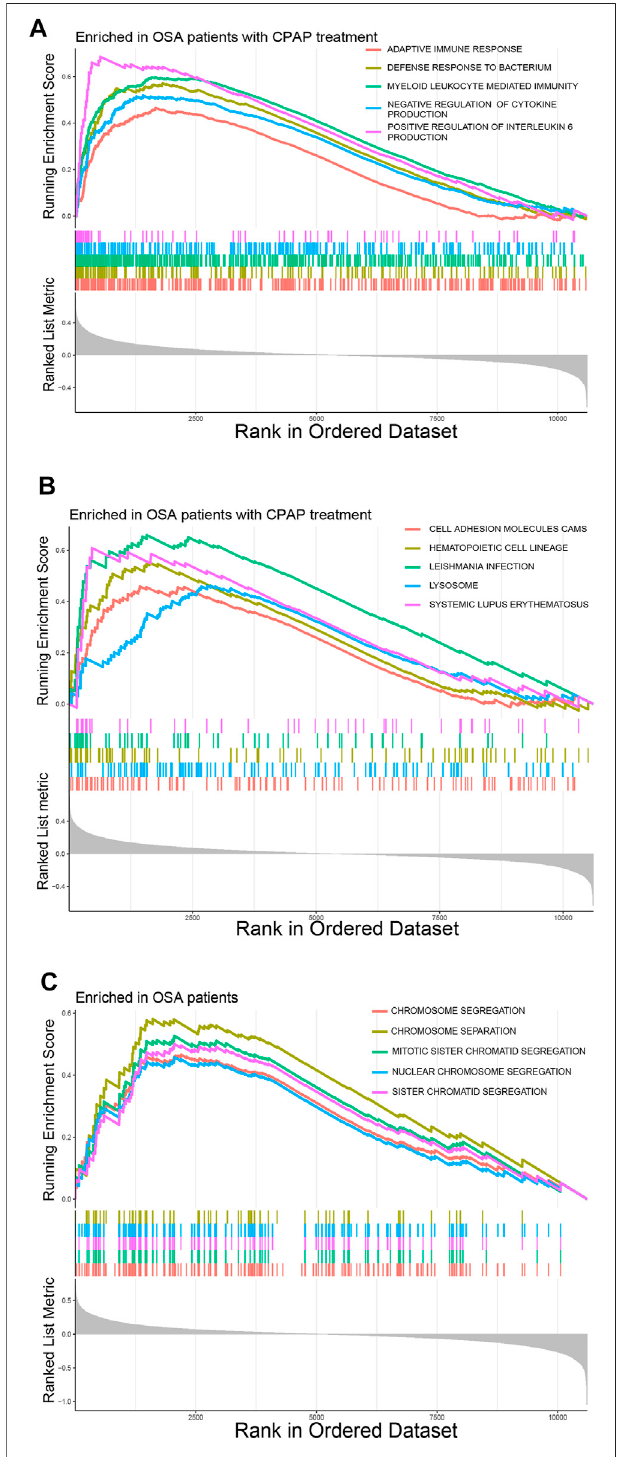
FIGURE 2 | (A) Common pathways in OSA patients according to the GSEA c5. go.v7.4. symbols.gmt dataset. (B) Common pathways in OSA patients that had undergone CPAP treatment according to the GSEA c2. cp.kegg.v7.4. symbols.gmt dataset. (C) Common pathways in OSA patients according to the GSEA c5. go.v7.4. symbols.gmt